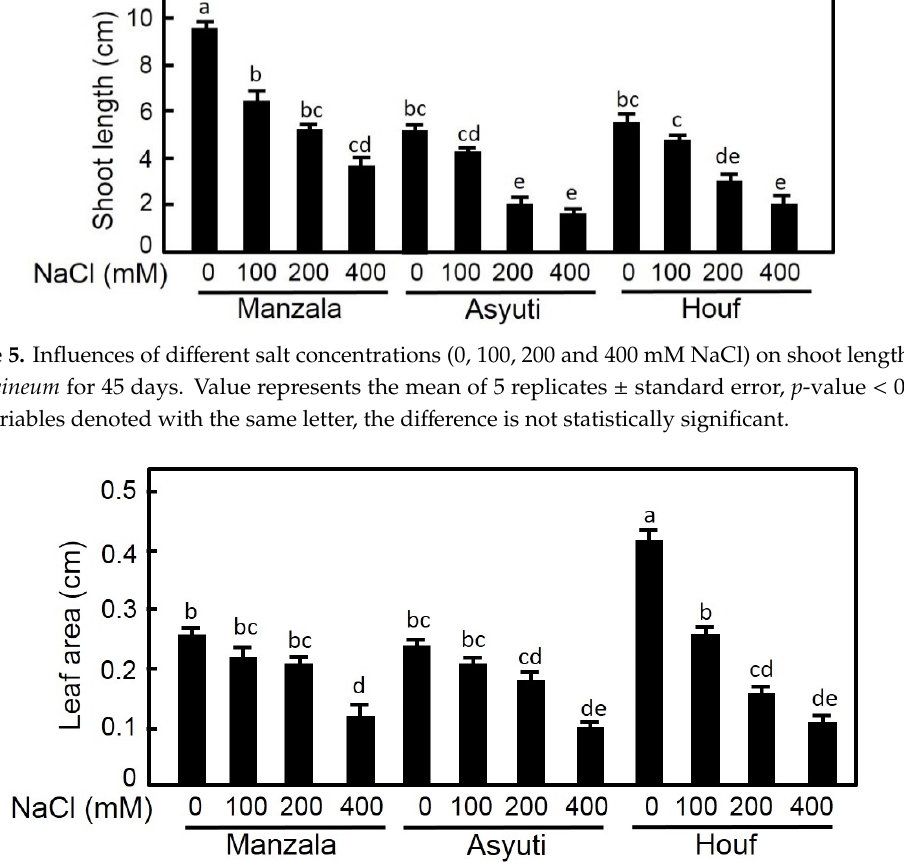
Figure 6. The effects of different salt concentrations (0, 100, 200 and 400 mM NaCl) on leaf area in Z. coccineum for 45 days. Value represents the mean of 5 replicates ± standard error, p -value < 0.05. For variables denoted with the same letter, the difference is not statistically significant.